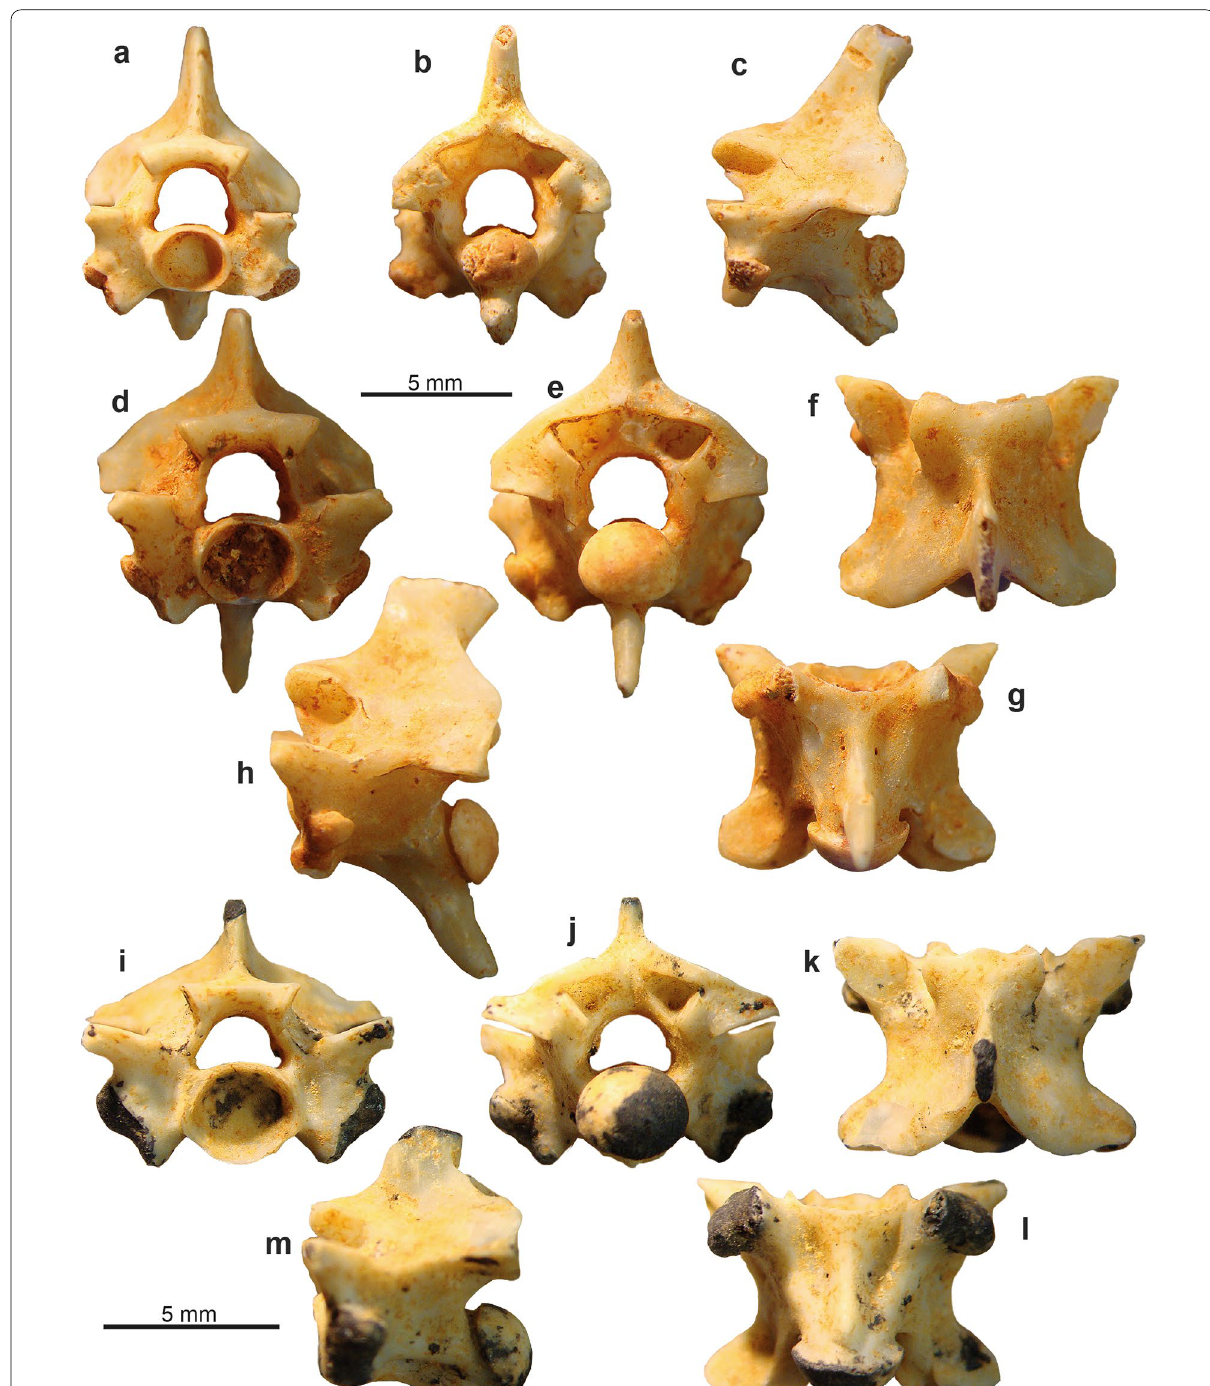
Fig. 82 Phosphoroboa filholii comb. nov. from the late Eocene of Escamps C, Phosphorites du Quercy: a – c anterior-most trunk vertebra (UM ECC 2572) in anterior ( a ), posterior ( b ), and left lateral ( c ) views; d – h anterior trunk vertebra (UM ECC 2575), more posterior than the previous one, in anterior ( d ), posterior ( e ), dorsal ( f ), ventral ( g ), and left lateral ( h ) views; i – m mid- to posterior trunk vertebra (UM ECC 2577) in anterior ( i ), posterior ( j ), dorsal ( k ), ventral ( l ), and left lateral ( m )